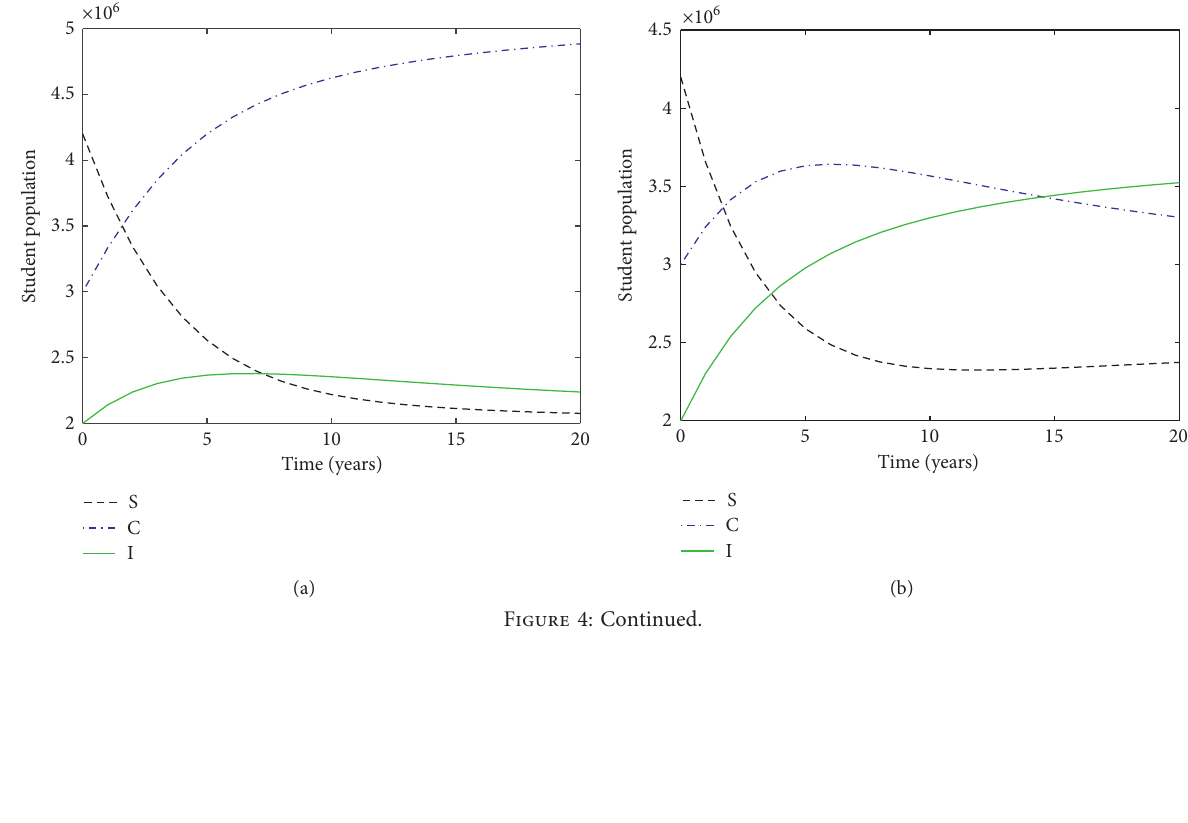
� 2 . 525; (b) σ � 0 . 02, α � 0, R � 1 . 923; (c) σ � 0 . 0 0